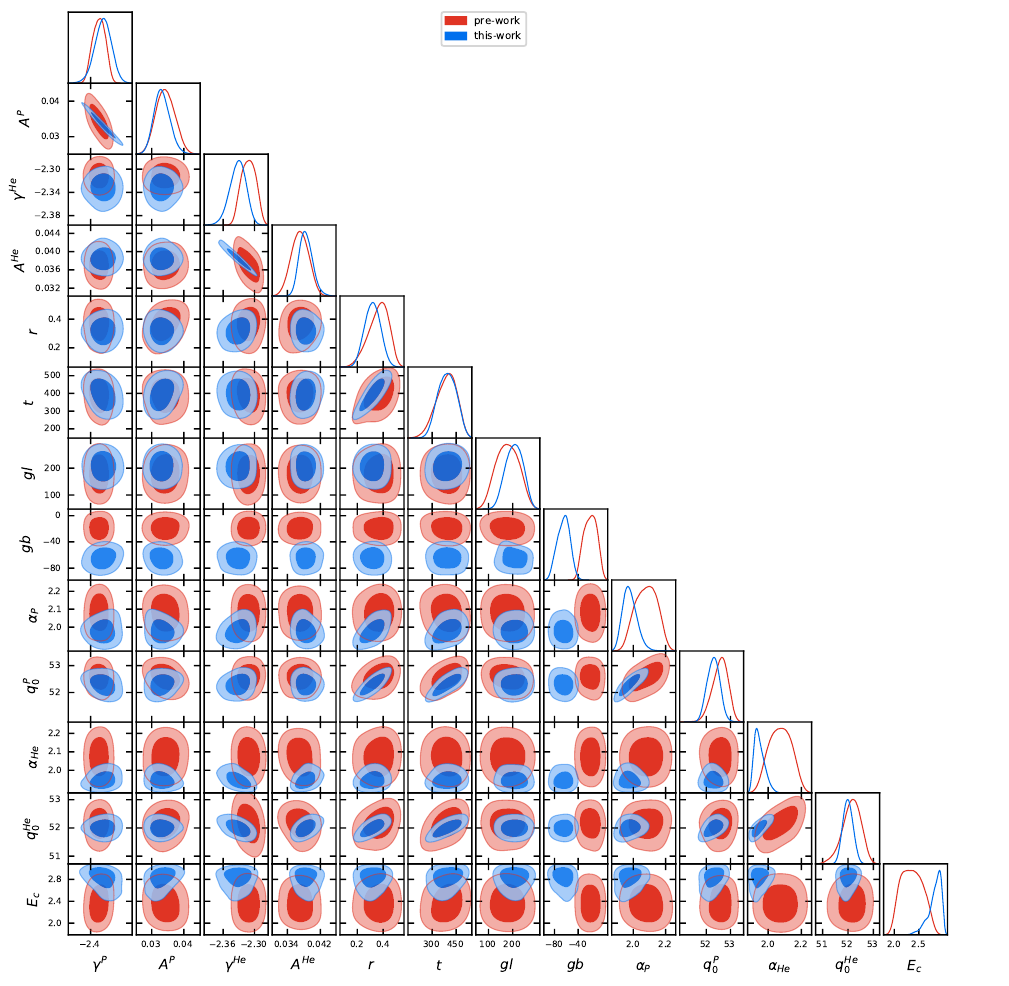
Figure 1. 2-dimensional correlation distributions of injection parameters as well as local source’s age and distance.